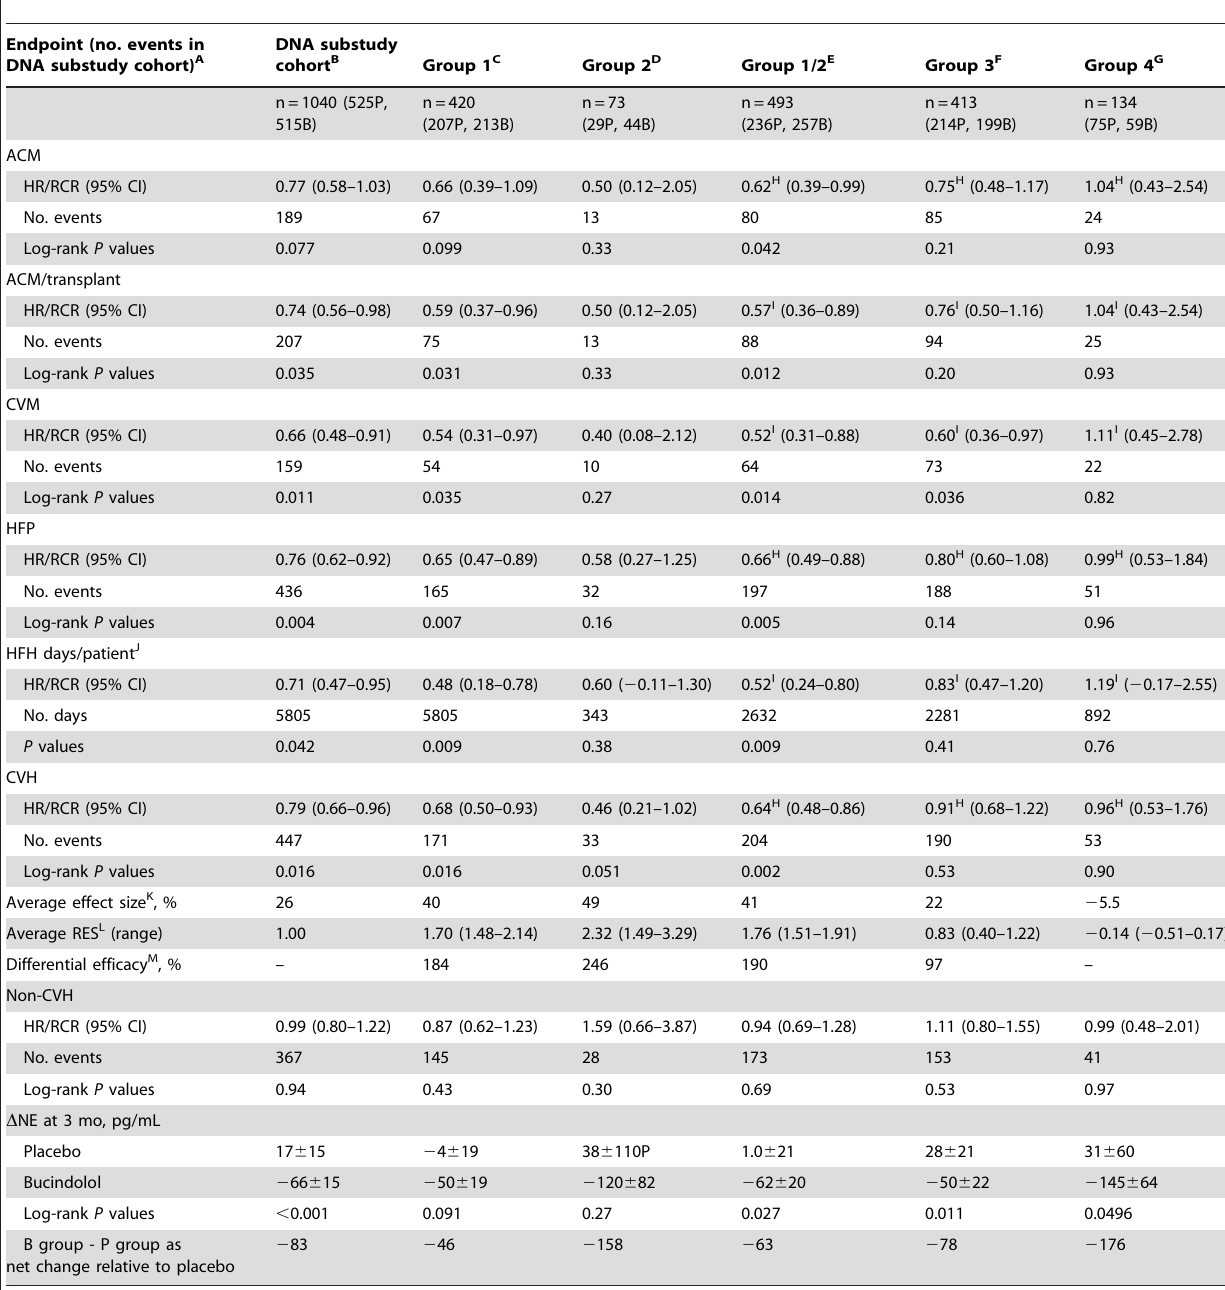
Table 2. Hazard ratios or relative change ratios for bucindolol/placebo (95% confidence intervals), number of events, and log-rank P values for clinical endpoints and norepinephrine change by genotype combination